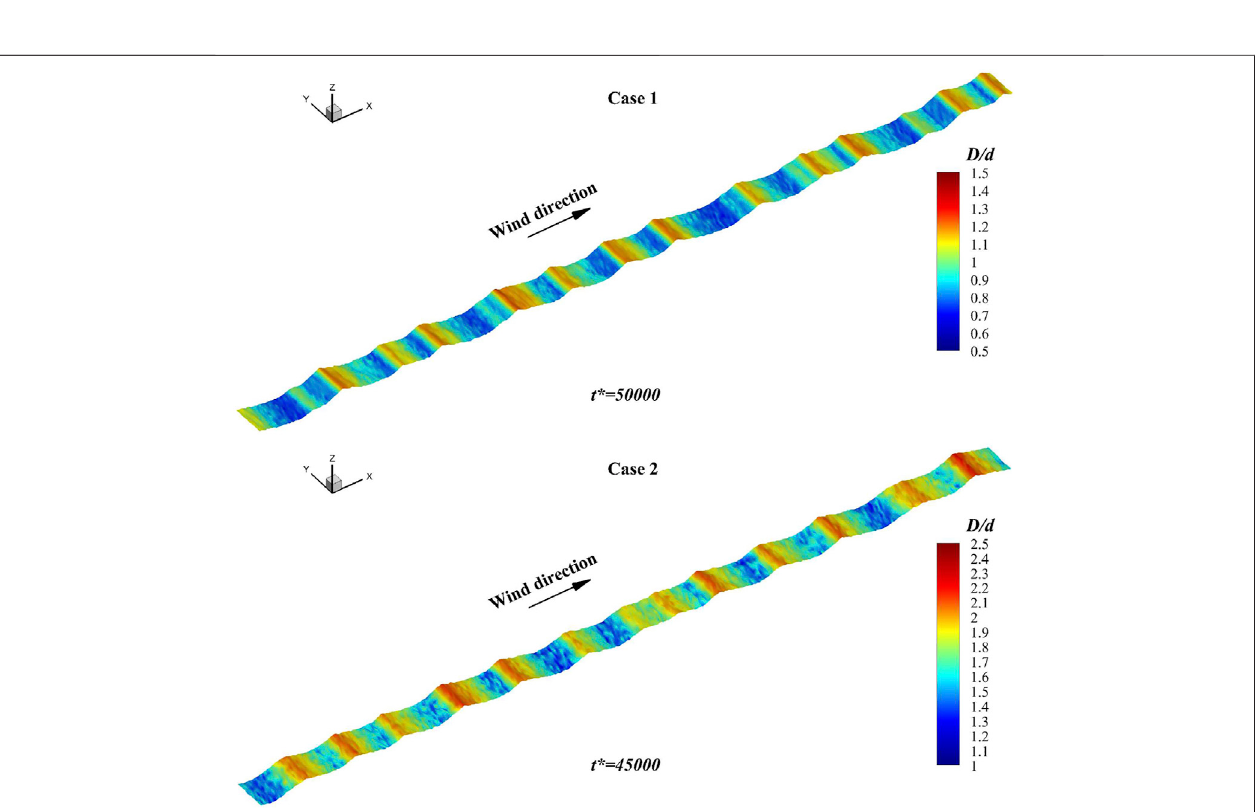
Frontiers in Physics |